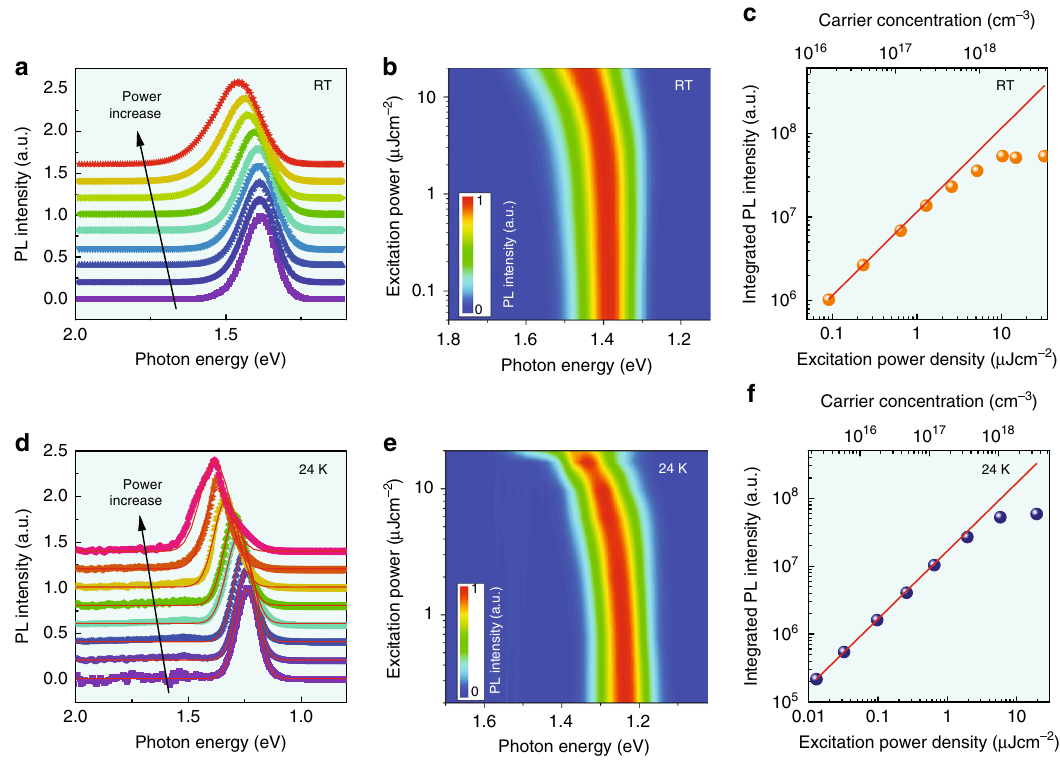
Fig. 1 Power-dependent photoluminescence spectra of the FASnI 3 thin fi lm. a Normalized PL spectra of FASnI 3 with excitation fl uence increasing from 0.03 to 34 μ Jcm − 2 at 293 K. b 2D pseudo-color plot of normalized PL spectra as a function of excitation power, showing the blue shift as the excitation density increases. The emission energy shifts from 1.38 to 1.46 eV at 293 K (with similar conditions the shifts are equal to 17 meV for FAPbI 3 , 6.5 meV for MAPbI 3 and 4 meV for MAPbBr 3 ). c Logarithmic plot of the integrated intensity of the emission as a function of power density — a linear dependence (red line) at low excitation fl uence is observed at 293 K. d Power-dependent PL spectra of FASnI 3 at 24 K. e 2D pseudo-color plot of normalized PL spectra as a function of excitation power, PL blue shift from 1.23 to 1.39 eV at 24 K. f Integrated PL intensity as a function of power density at 24